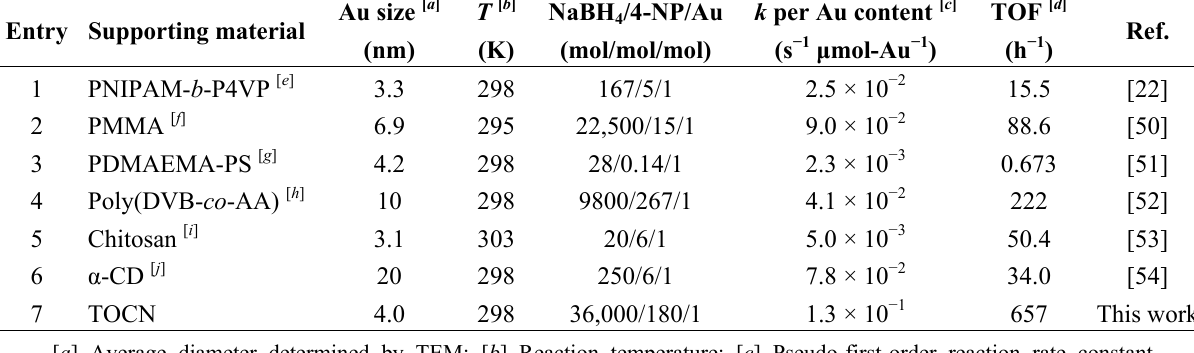
Table 1. Recent studies on the catalytic reduction efficiency of 4-NP over Au nanocatalysts. Entry Supporting